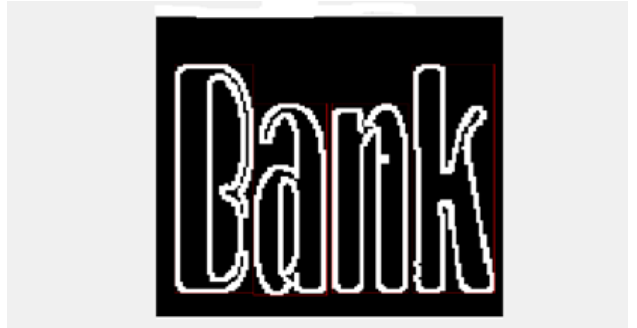
Figure 4. Textual images after applying adaptive contrast map.